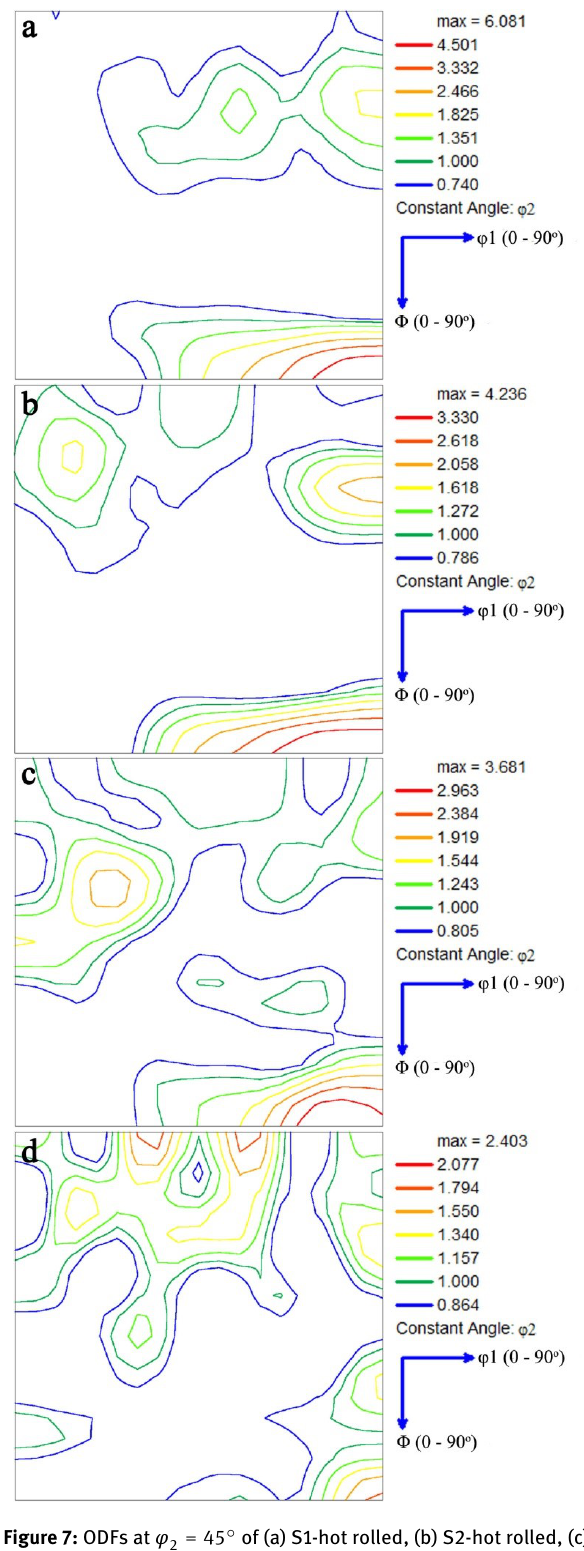
Figure 7: ODFs at φ 2 = 45 ∘ of (a) S1-hot rolled, (b) S2-hot rolled, (c) S1-normalized, and (d)